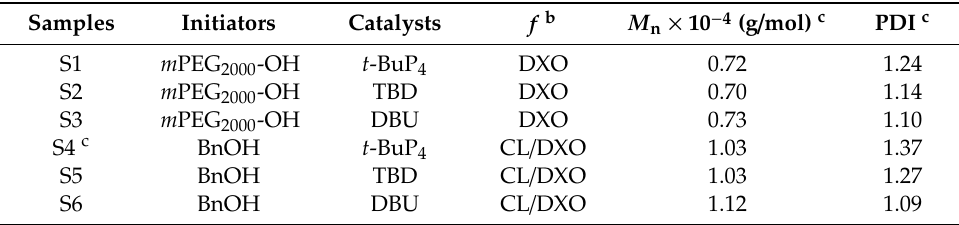
Table 2. Characterization data of DXO based copolymers a Table 2 . Characterization data of DXO based copolymers a .